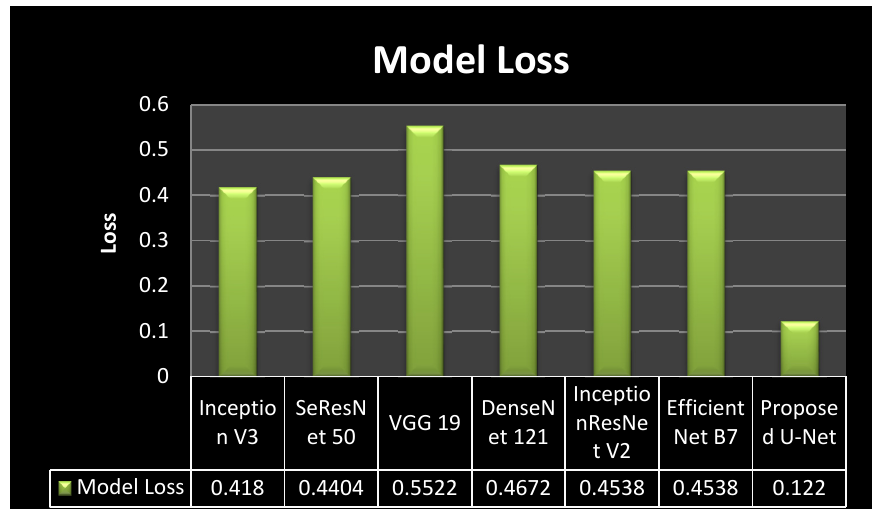
Figure 9. Model Loss Comparison Graph.